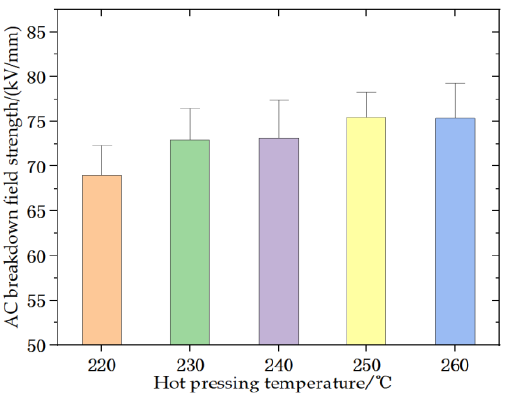
Figure 7. AC breakdown strength of oil-impregnated paper with different hot pressing tempera- tures.